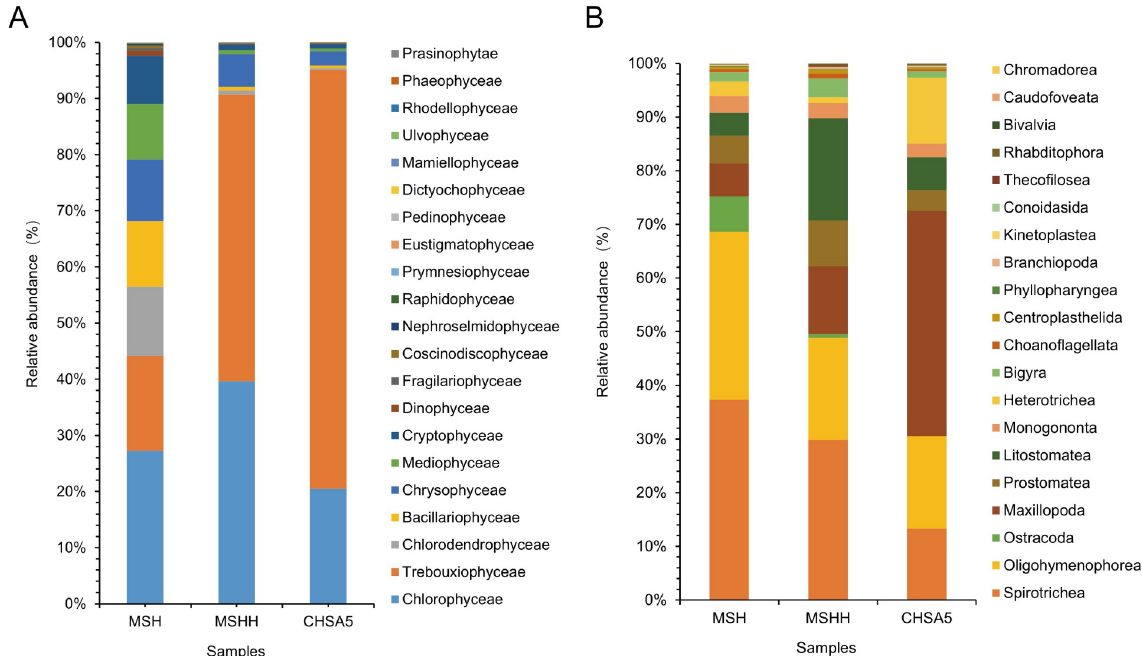
Fig 6. The relative abundance of phytoplankton (A) and zooplankton (B) at the class level in MSH, MSHH, and CHSA5 test waters. MSH: the mosquito was living in water from the Meishe river alone. MSHH: the mosquito was living in water from the Meishe river supplemented with wild Chlorella HOC5. CHSA5: the mosquito was living in water from the Meishe river supplemented with recombinant Chlorella CHSA5.